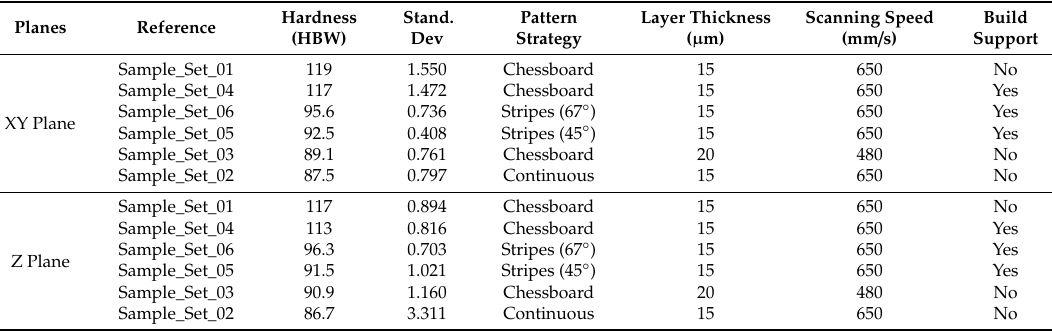
Table 9. Hardness Values Found on XY and Z Planes Measured on Cut / Polished